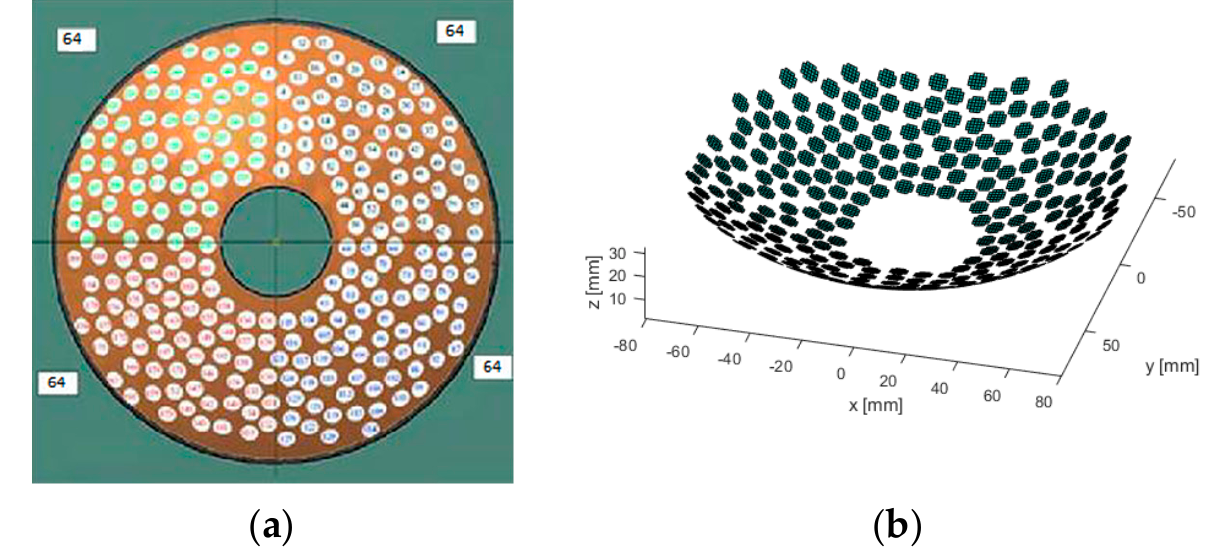
Figure 1. The random distribution of elements in four quadrants with 64 elements in each quadrant. The diameter of the array is 180 mm and the central hole is 38 mm in diameter. ( a ) Front face, ( b ) 3D view .